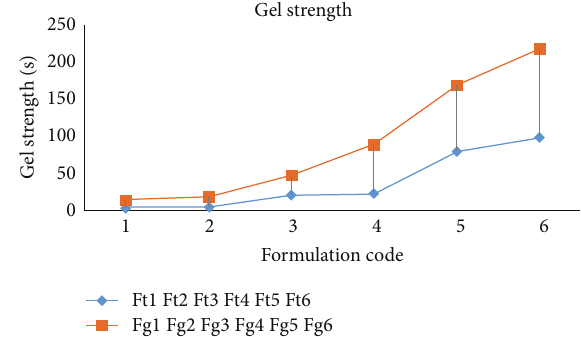
Figure 1: Graphical representation of gel strengths of